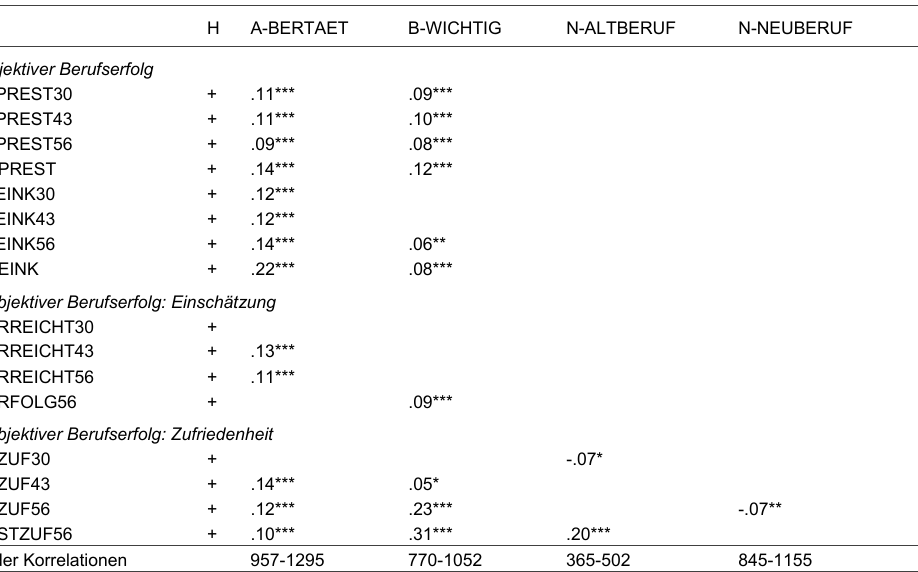
Tabelle 1 : Berufserfolg und Kontinuität der Berufslaufbahn: Korrelationen (Tau